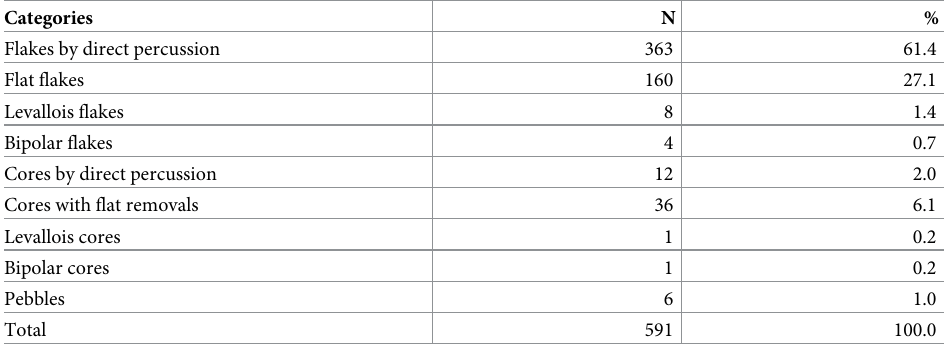
Table 6. Sant’Agostino layer A1. Blanks of retouched pieces . Indeterminate flakes and indeterminate blanks are excluded.